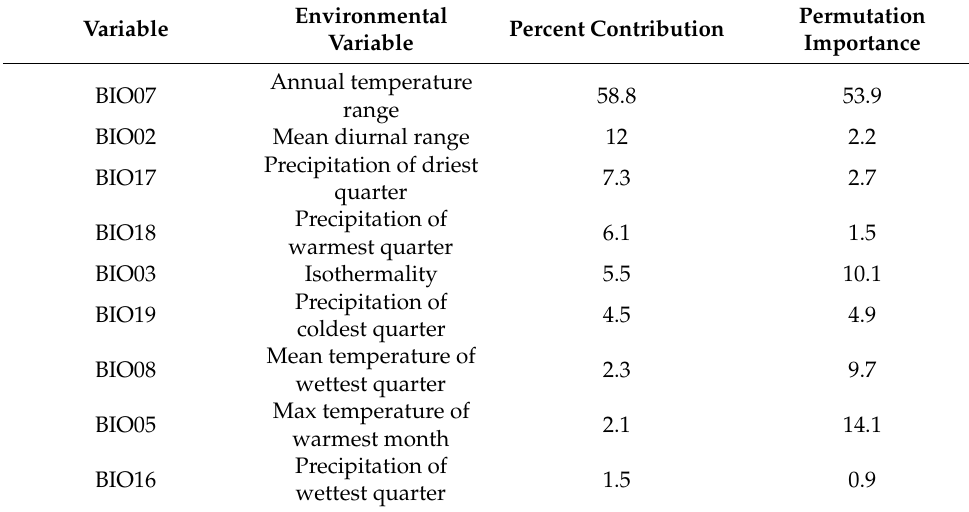
Figure 2. ROC curve and AUC values for the model. The average test AUC for the replicate runs was 0.844, and the standard deviation was 0.012. Table 1. Climate variables and their